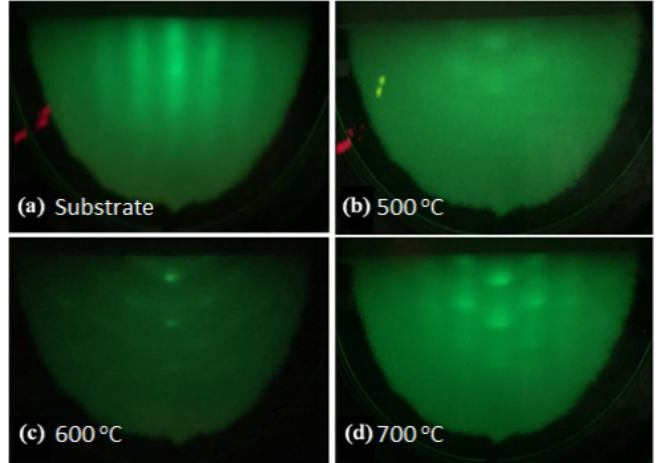
Figure 1. RHEED patterns of ( a ) substrate: 2D MoS 2 on c-sapphire, ( b ) T1: GaN films grown on MoS 2 at 500 °C, ( c ) T2: GaN films grown on MoS 2 at 600 °C and ( d ) T3: GaN films grown on MoS 2 at 700 °C.